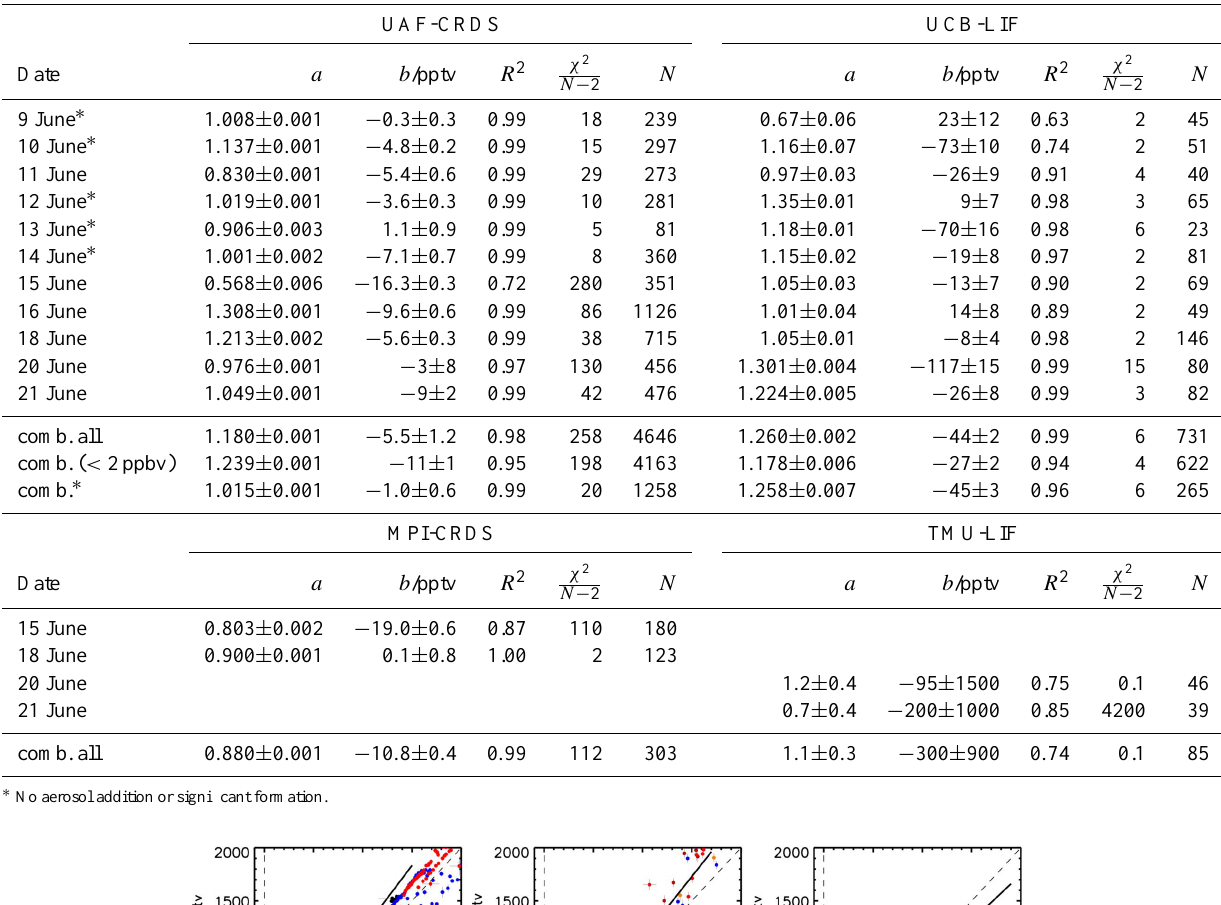
Table 3. Results of the linear regression analysis between N 2 O 5 data taking NOAA-CRDS as reference ( a : slope, b : intercept, R 2 : squared 2 correlation coefficient, χ : sum of squared residuals divided by the degrees of freedom, N : number of data points). Data are averaged to N − 2 1min time intervals.